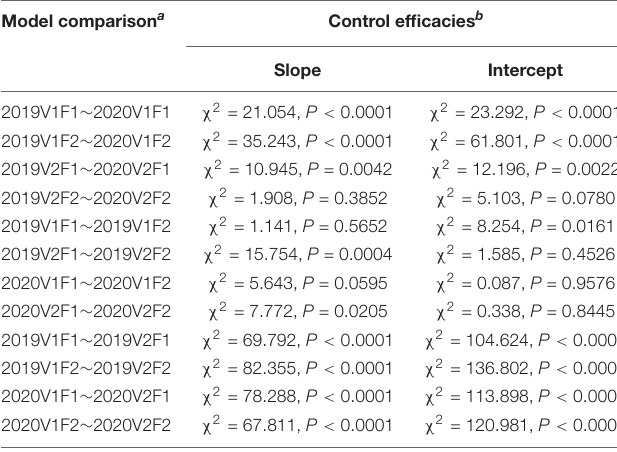
TABLE 9 | Comparative analyses of the relationship models between control efficacies and active ingredient dosages of two fungicides on different resistant varieties.